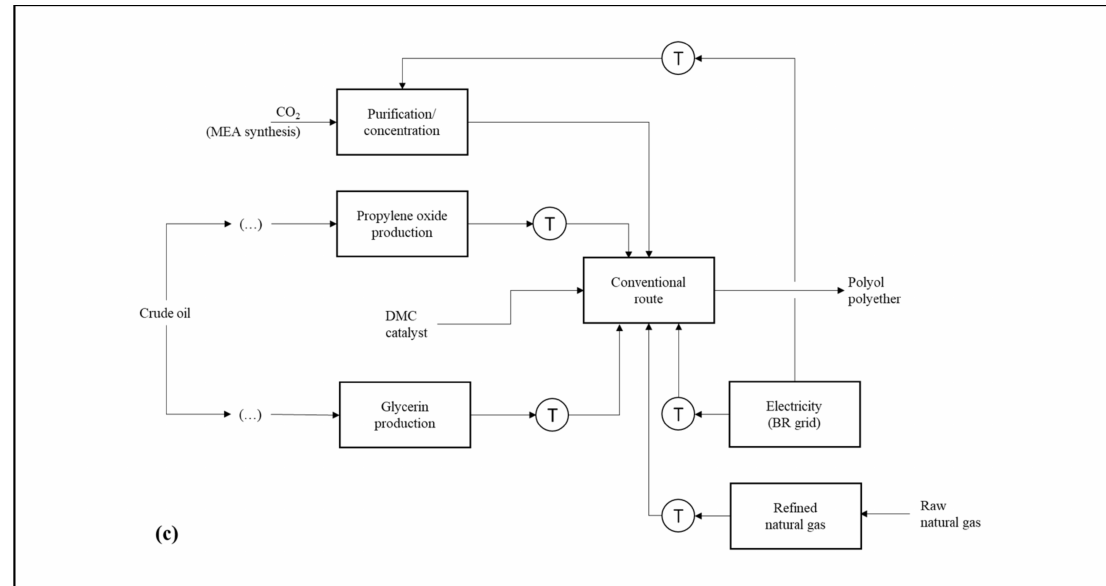
Figure 1. Product systems that describe the PPG synthesis applying: ( a ) the conventional route using DMC as catalyst (R1); ( b ) the vegetable route, including the preparation of epoxidized soybean oil (R2); and ( c ) the CO 2 -based route, comprising CCU coupled to the polyol manufacturing plant